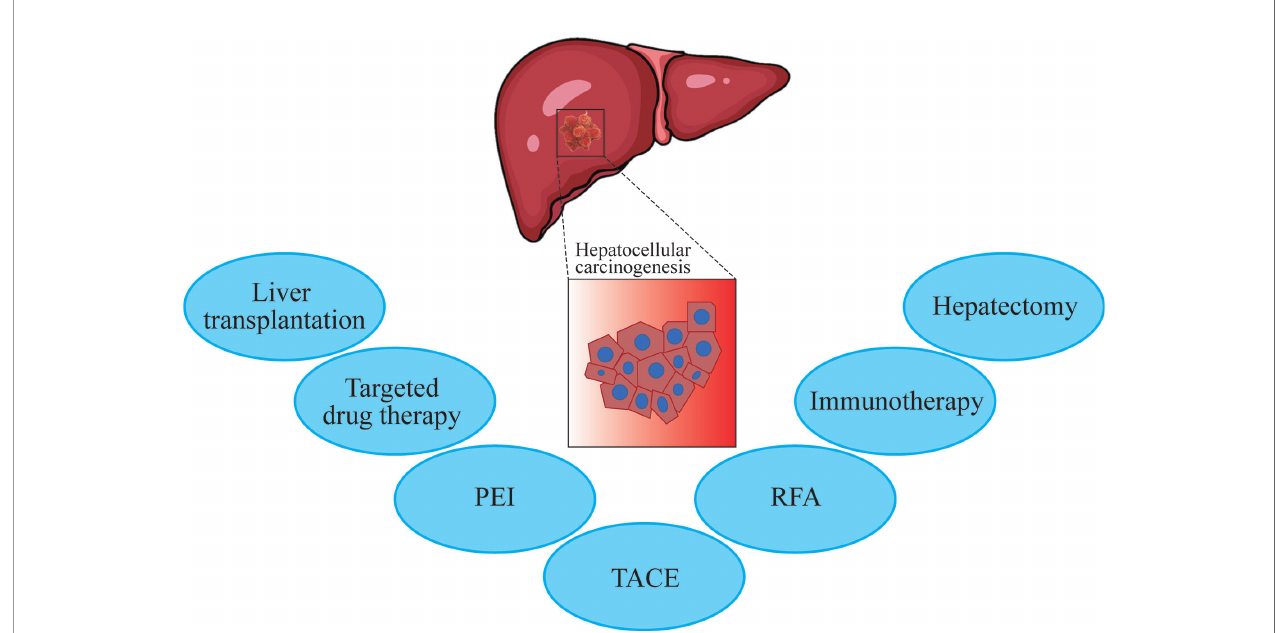
FIGURE 1 | The current treatments for liver cancer include hepatectomy, immunotherapy, transcatheter arterial chemoembolization (TACE), radiofrequency ablation (RFA), percutaneous ethanol injection (PEI), targeted drug therapy (sorafenib/FOLFOX4), and liver transplantation (UCSF standard). According to the patient ’ s condition, such as the degree of liver cirrhosis, liver function (child grade), number of tumors, size of tumors, and metastasis, clinicians select the appropriate treatment plan or perform combination